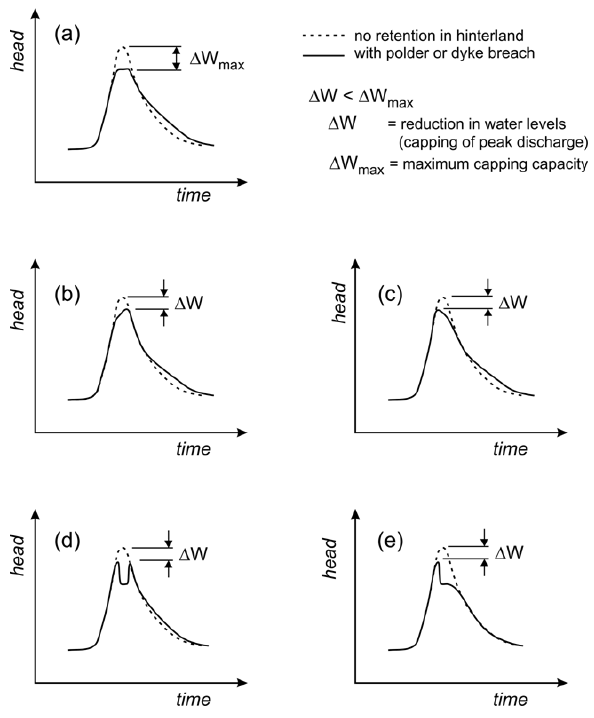
Fig. 4. Theoretical depiction of the strategy for optimising the con- trol of the polder filling to its maximum capacity in order to attain maximum capping of the peak discharge of a river’s flood hydro- graph. In (a) , the times and duration of opening and closing the inlet polder gates are optimised to attain the largest peak discharge capping. The inlet gate is opened too soon in (b) and too late in (c) , which in both cases diminishes the capping potential of the polder. Flood water diversion through a dyke breach into a contained hin- terland area (d) or into an area of unlimited retention capacity (e) also results in less than optimal capping of the discharge